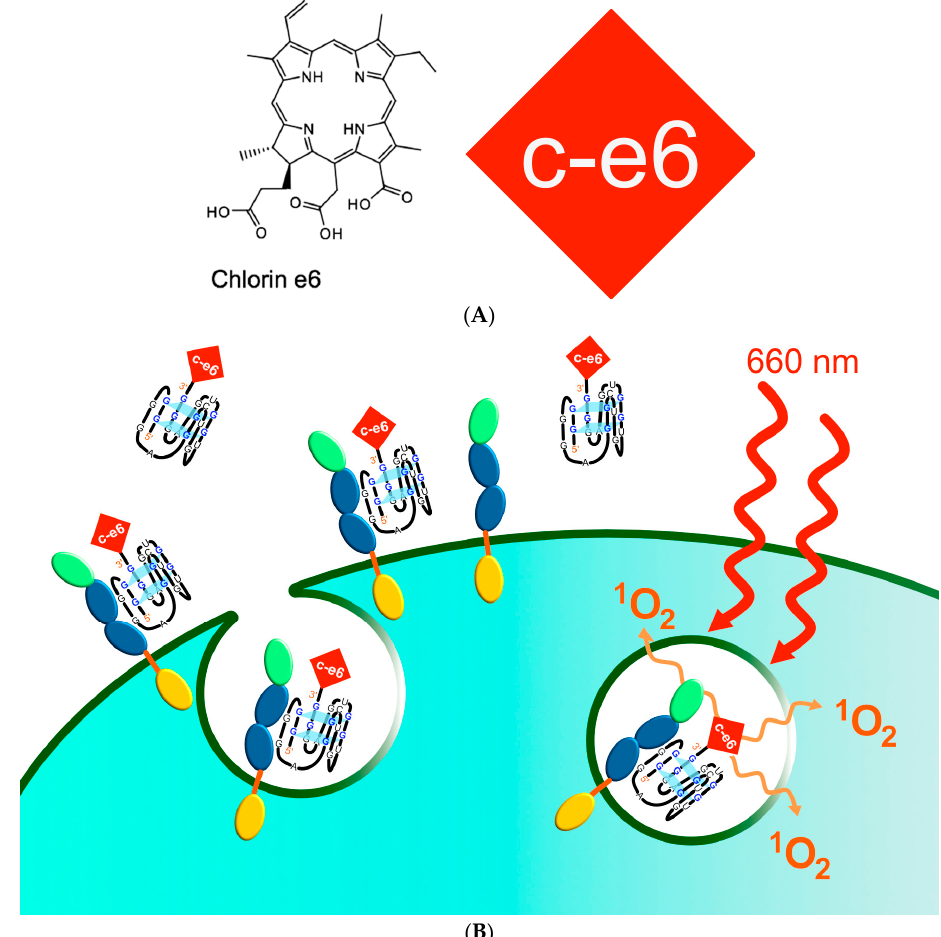
Figure 5. Chlorin e6 (c-e6) derivatized charomer AIR-3A-ce6 was internalized by IL-6R presenting cells leading to their destruction after illumination with appropriate light [34]. Schematic drawing of the aptamer mediated targeted photodynamic therapy (PDT). C-e6 ( A ) was covalently linked to the IL-6R specific aptamer (here schematically depicted as a G-quadruplex structured molecule); ( B ) This aptamer derivative was incubated with appropriate cells which did not survive after illumination with light of 660 nm wavelength ( red waved lines) which is absorbed by ce-6 leading to the generation of singlet oxygen ( 1 O 2 , orange waved lines) [34]; different colored ellipses of receptors symbolize different domains, extracellular domains in blue and green, intracellular part yellow.